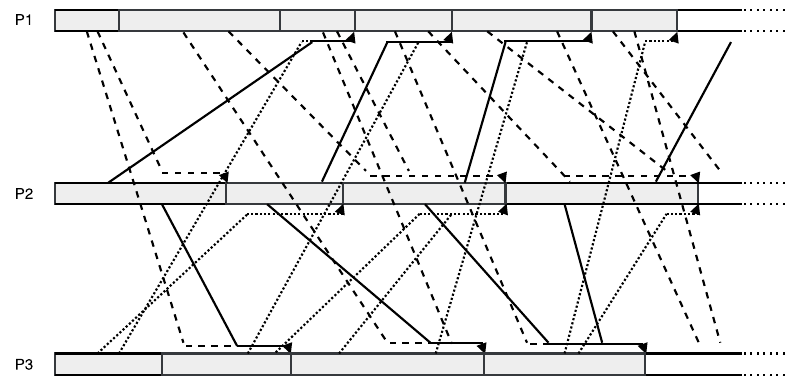
Figure 3. Example of asynchronous two-stage iterations with flexible